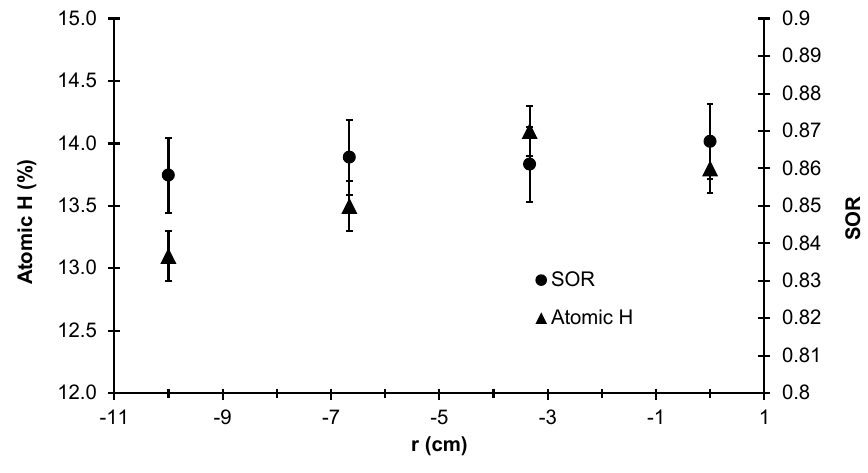
Figure 25. Open-loop drift and spatial non-uniformity in the four radial wafer